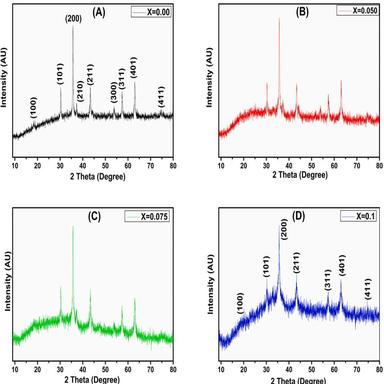
XRD pattern of CoFe2-xSmxO4 (a) x = 0.0 (b) x = 0.050 (c) x = 0.075 (d) x = 0.1 ferrites.